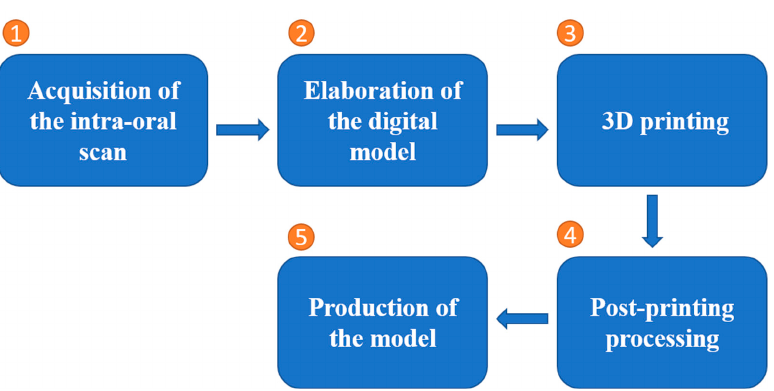
Figure 2. Five steps of clinical 3D printing workflow in dentistry.